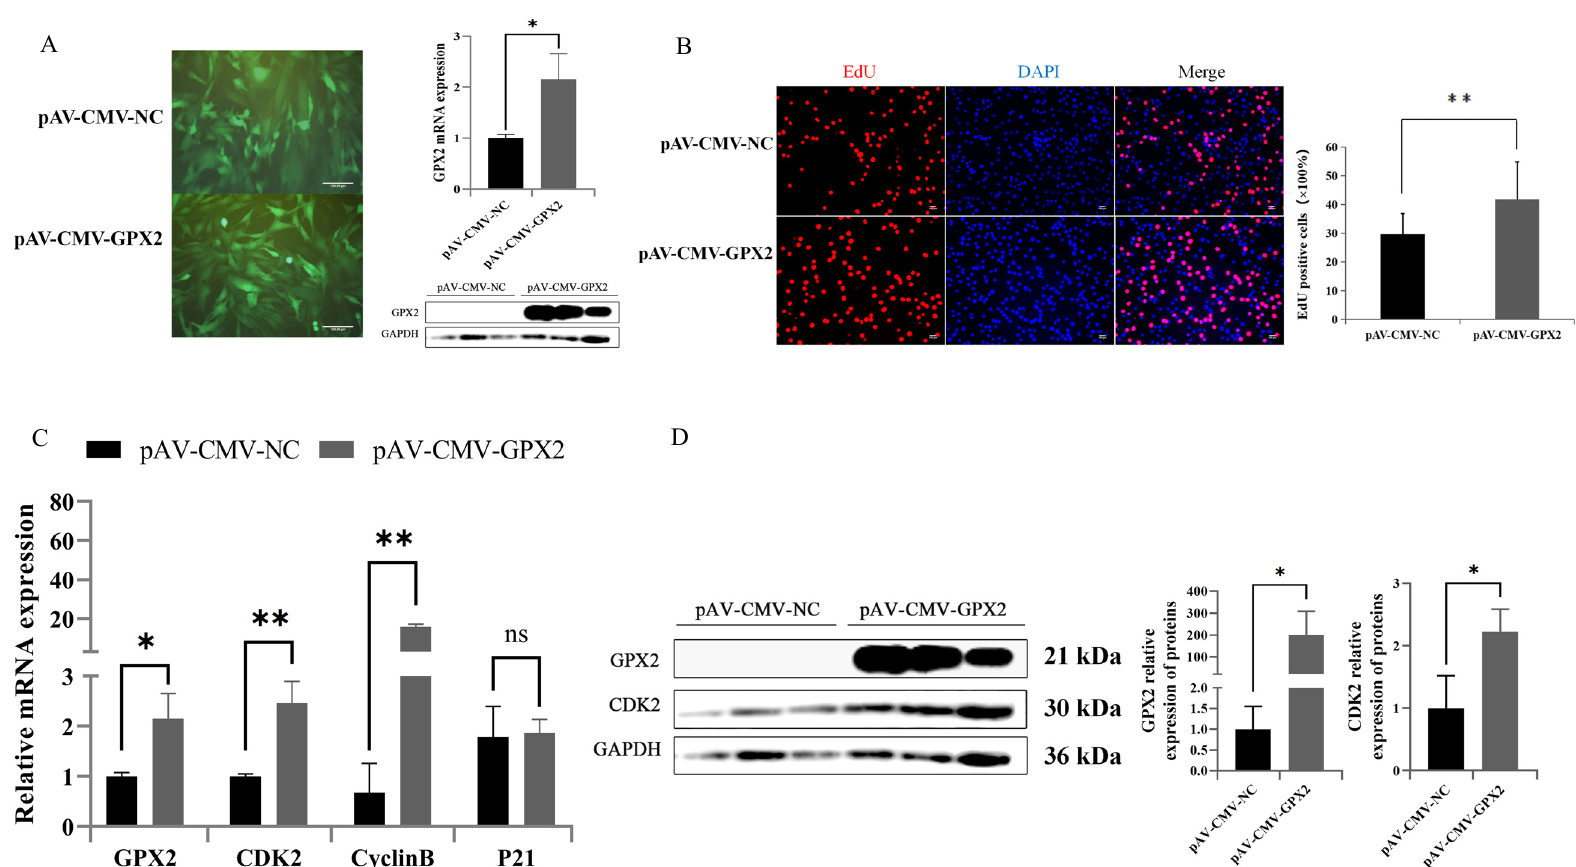
Figure 6. Overexpression of GPX2 inhibited the proliferation of C2C12 cell. ( A ) C2C12 infected with adenovirus carrying GPX2, and the mRNA and protein of GPX2 stable expressed in the C2C12 cell. ( B ) Representative immunostaining images comparing the cells in the proliferative phase from negative control and overexpression of GPX2, the nuclei are stained with Hoechest 33342. Quantification graph showing the percentage of cells positive for the red cell (EdU). ( C ) mRNA expression of proliferation related gene between overexpression of GPX2 and control group. ( D ) Protein levels for GPX2 and CDK2 at 48 h after overexpression of GPX2 in the C2C12 cell. In addition, abundance analysis was compared with the GAPDH protein. * indicates p < 0.05, ** indicates p < 0.01, ns indicates not